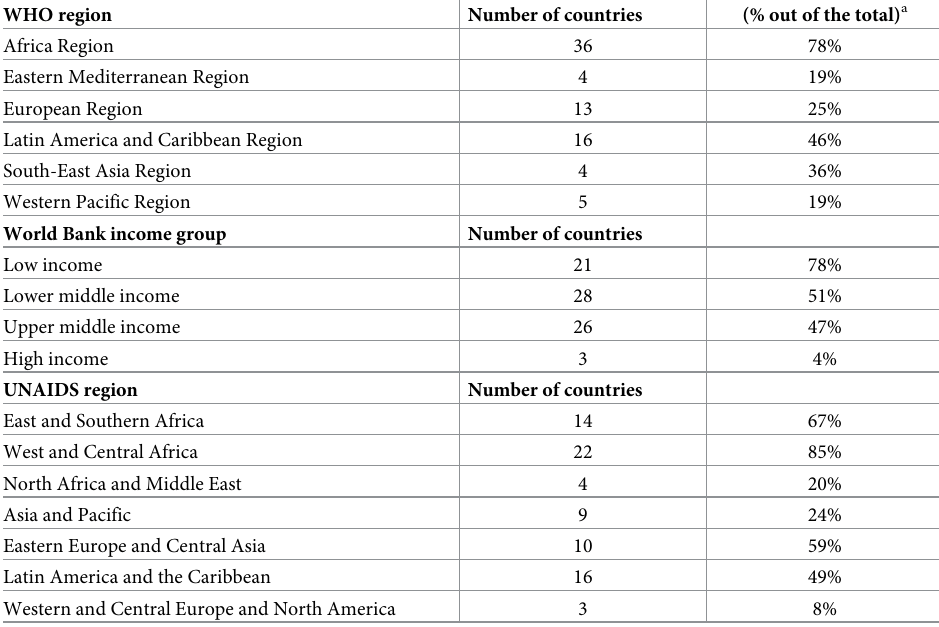
Table 1. Number of countries included by WHO region and World Bank income group (N = 78). WHO